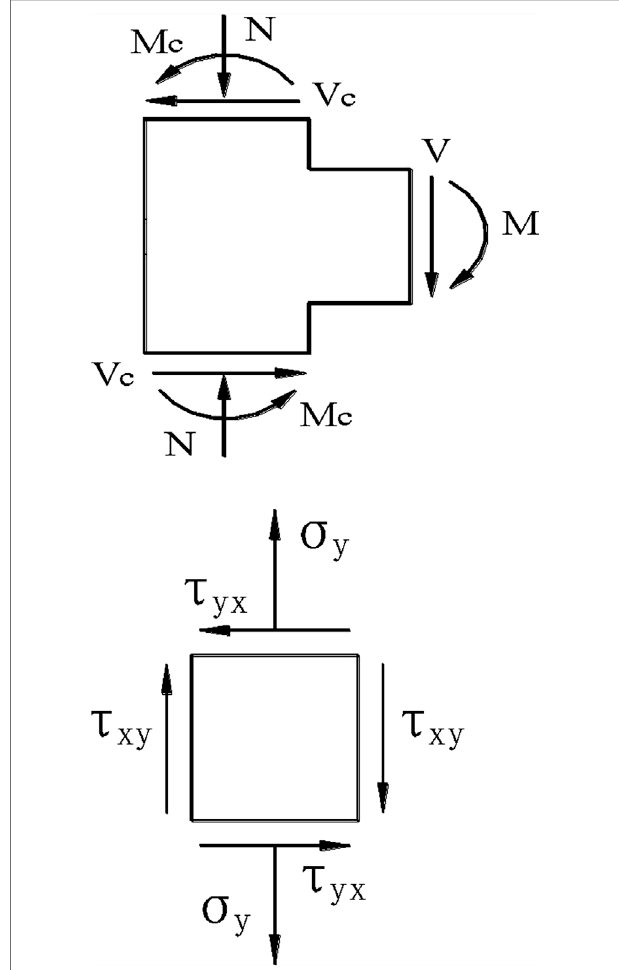
FIGURE 13 | Stress state of joint